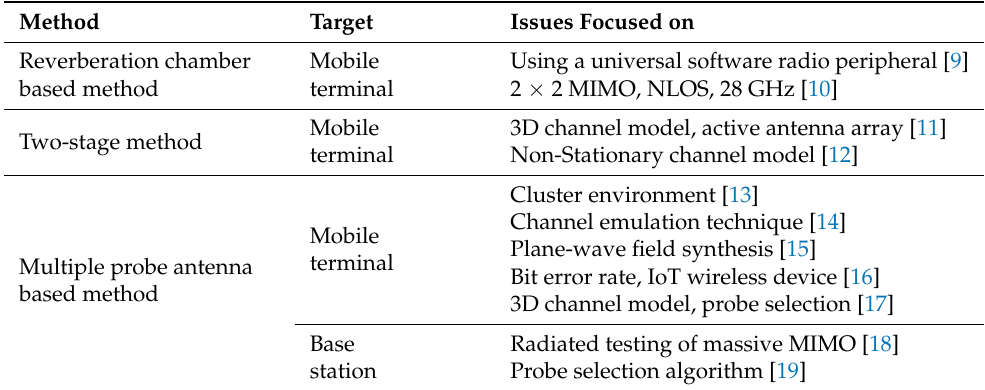
Table 1. Novelty of the present